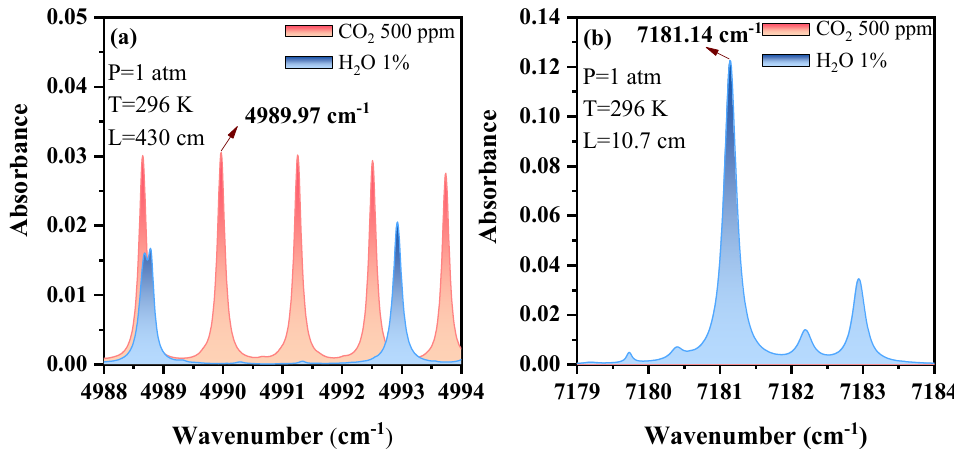
Figure 1. Simulated absorbance of CO 2 and H 2 O in the selected wavenumber range ( a ) 4988-4994 cm −1 and ( b ) 7179-7184 cm −1 with the HITRAN